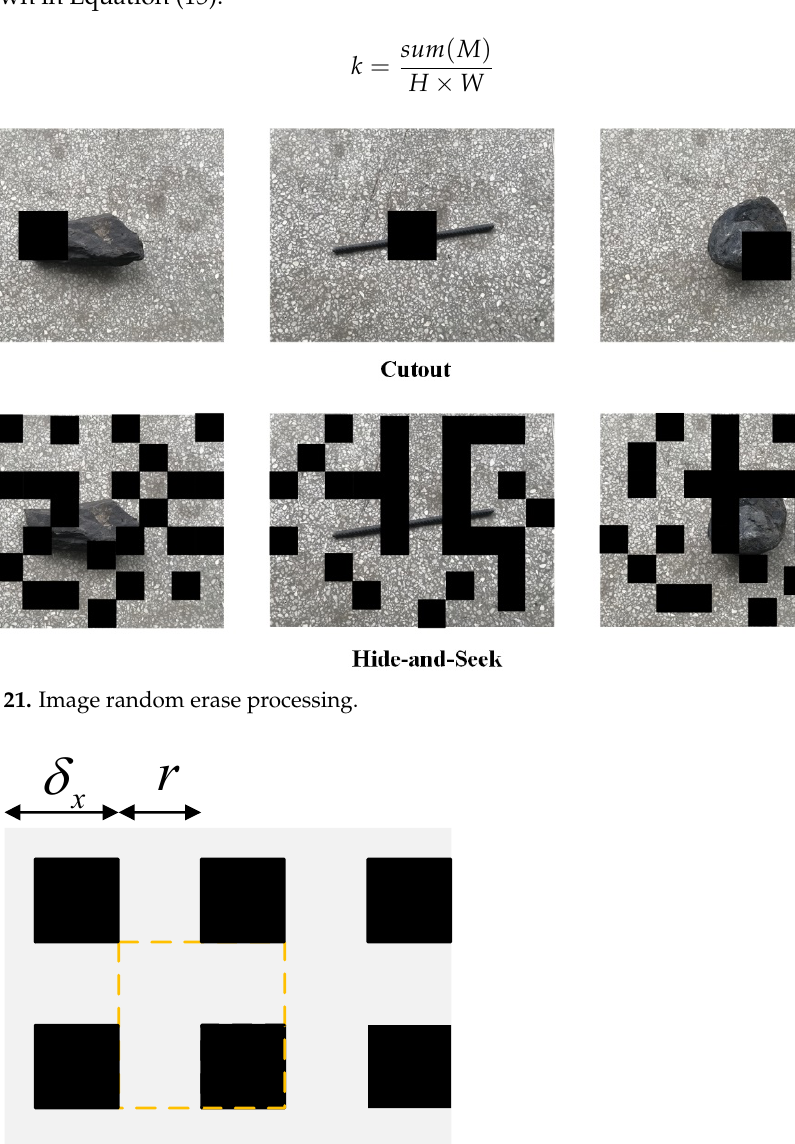
Figure 21. Image random erase processing.